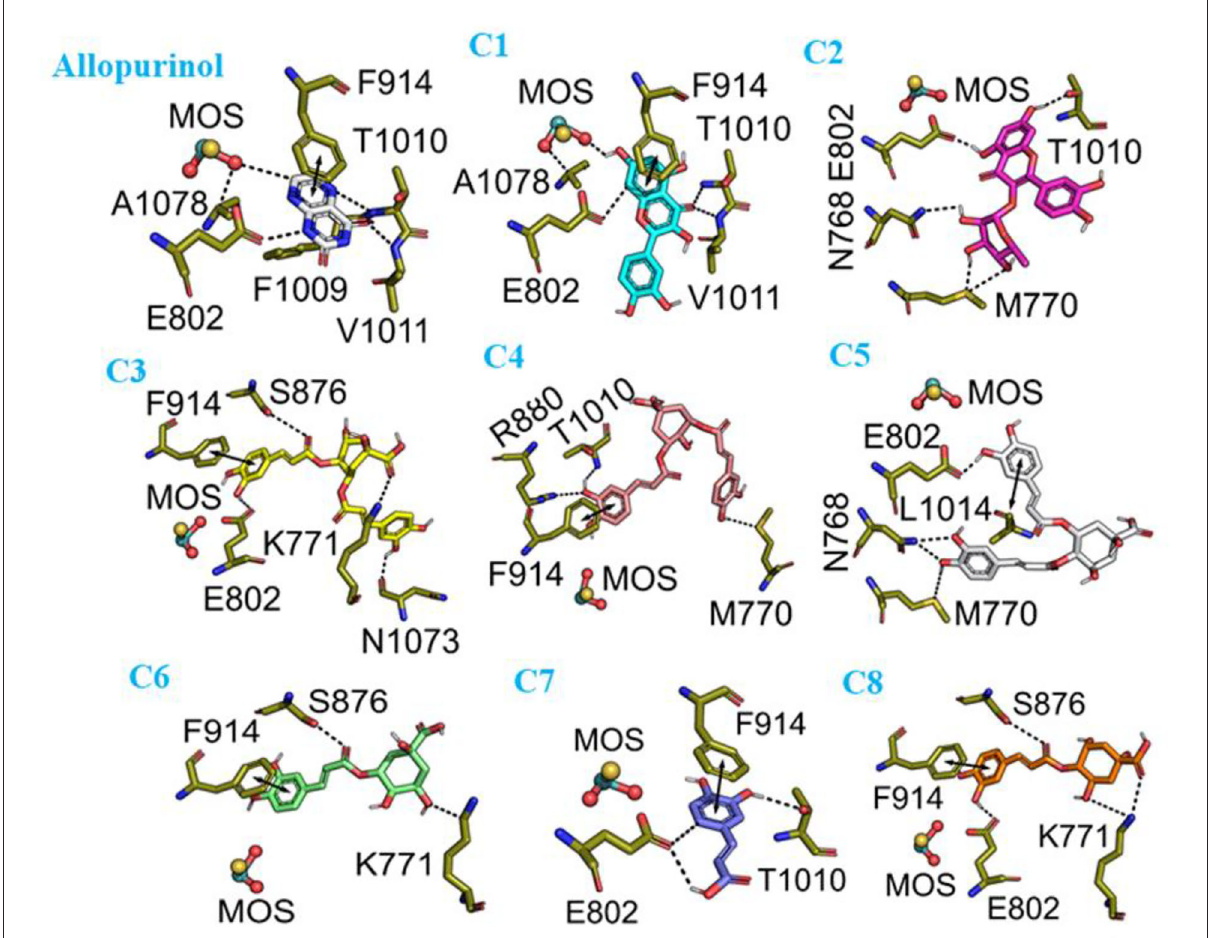
FIGURE4 The molecular docking interaction of phenolic compounds (C1–C8) with xanthine oxidase (XO). C1, quercetin; C2, quercetin-3-rhamnoside; C3, 4,5-O-dicaffeoylquinic acid; C4, 3,5-O-dicaffeoylquinic acid; C5, 3,4-O-di-caffeoylquinic acid; C6, 4-O-caffeoylquinic acid; C7, 3-O-caffeoylquinic acid; C8, caffeic